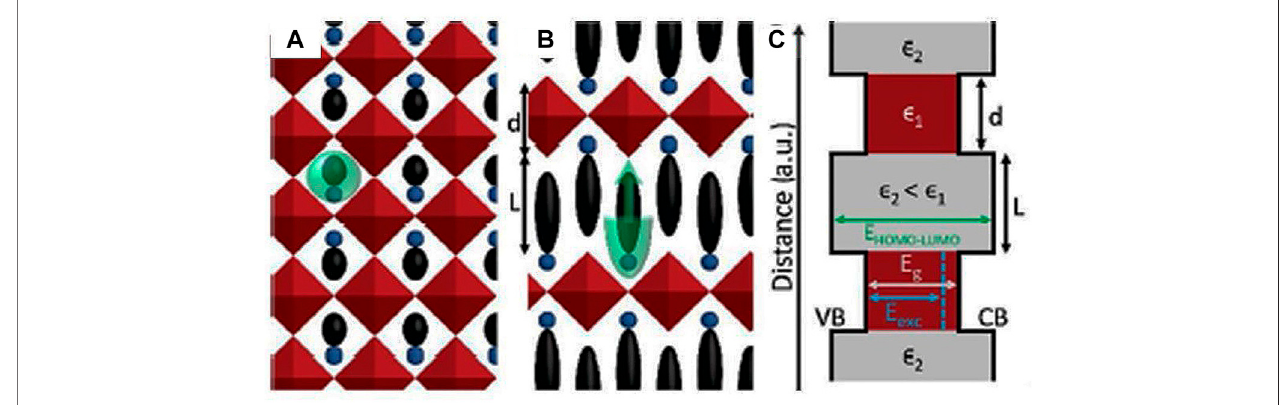
FIGURE3|(A) Projectionschematicofthe3DHP(colorcodesareasfollows:reddescribesacorner-sharedinorganicnetworkofoctahedralmetalhalide,blueand black describes the interstitial position of the organic cations, and green emphasizes the size restriction on cations). (B) Projection of the 2D HP along the c-axis (color codes are as follows: blue and black represents the organic alteration, red represents the corner-shared inorganic layers, and green represents the restriction on area cross section of organic cation and not on the length). d (cid:1) inorganic layer thickness and L (cid:1) organic layer thickness for n (cid:1) 1. (C) Energy band diagram of 2D HP structures ( E g and E exc denote the electronic and optical bandgap). Blue color represents the E exc . The fi gure is reprinted with permission from Straus and Kagan et al. (2018), copyright 2017, American Chemical